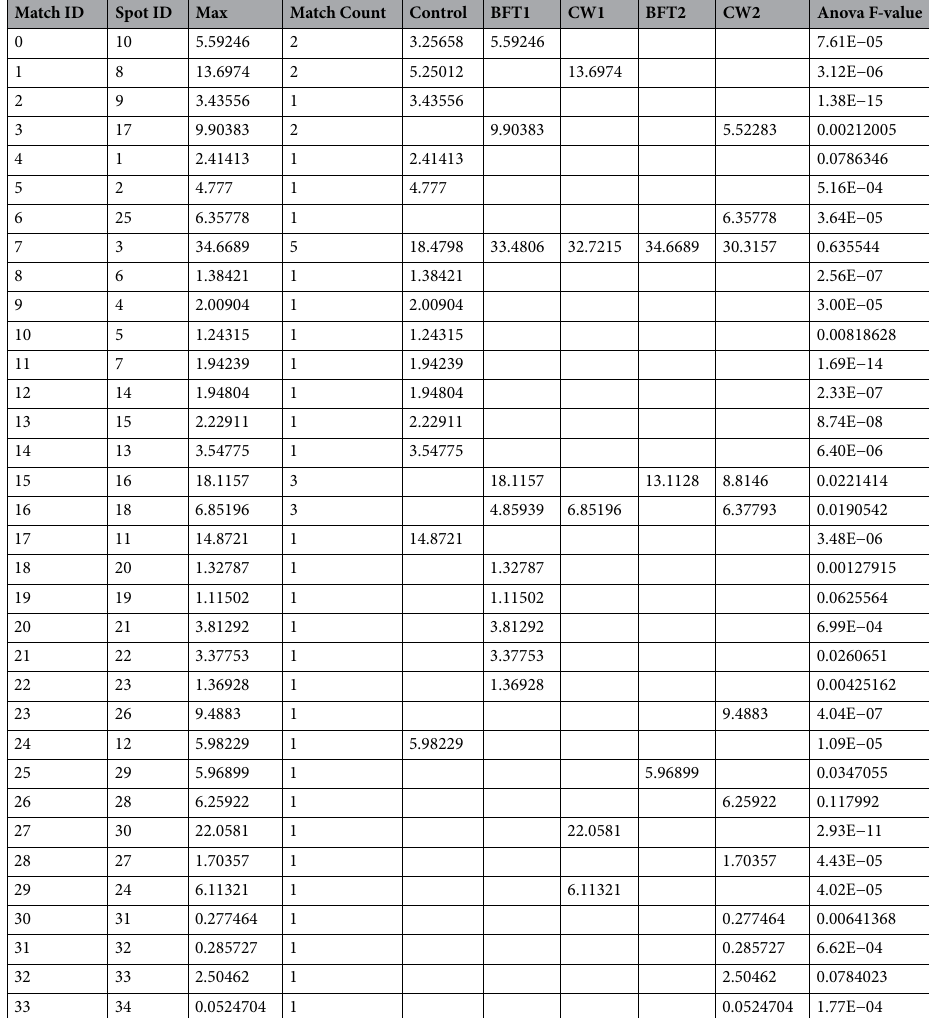
Table 3. Class analysis of differently expressed proteins from different